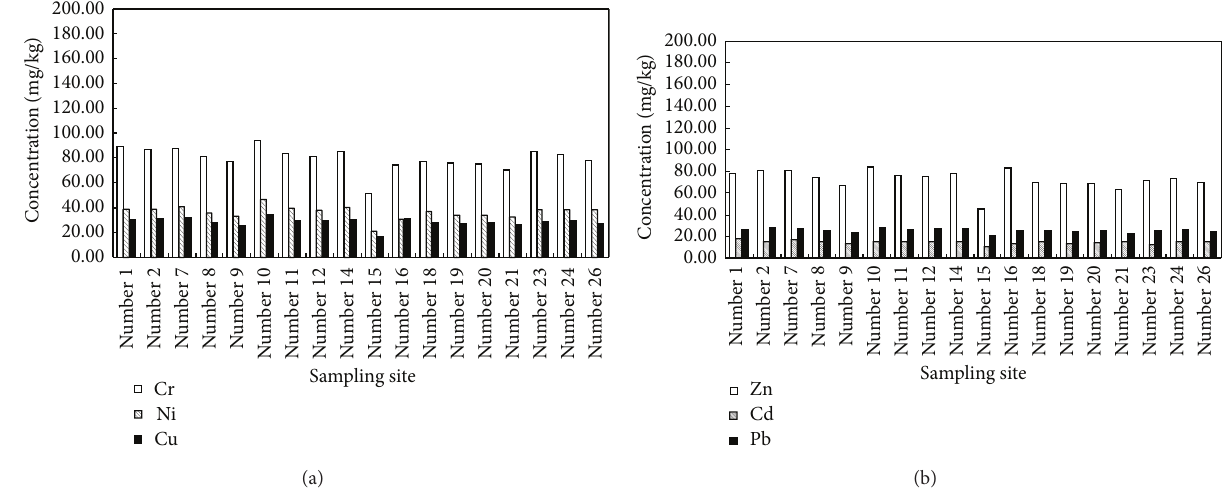
Figure 2: Spatial distribution of heavy metals in surface sediments of Bohai